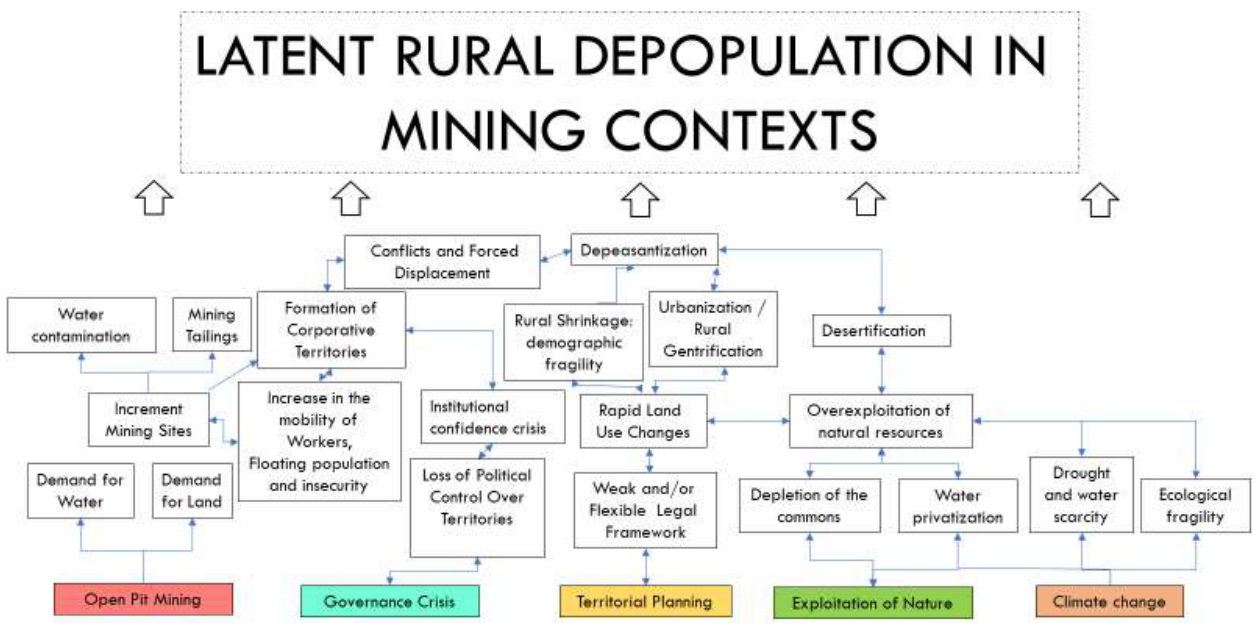
Figure 1. Model of latent rural depopulation due to open-pit mining.